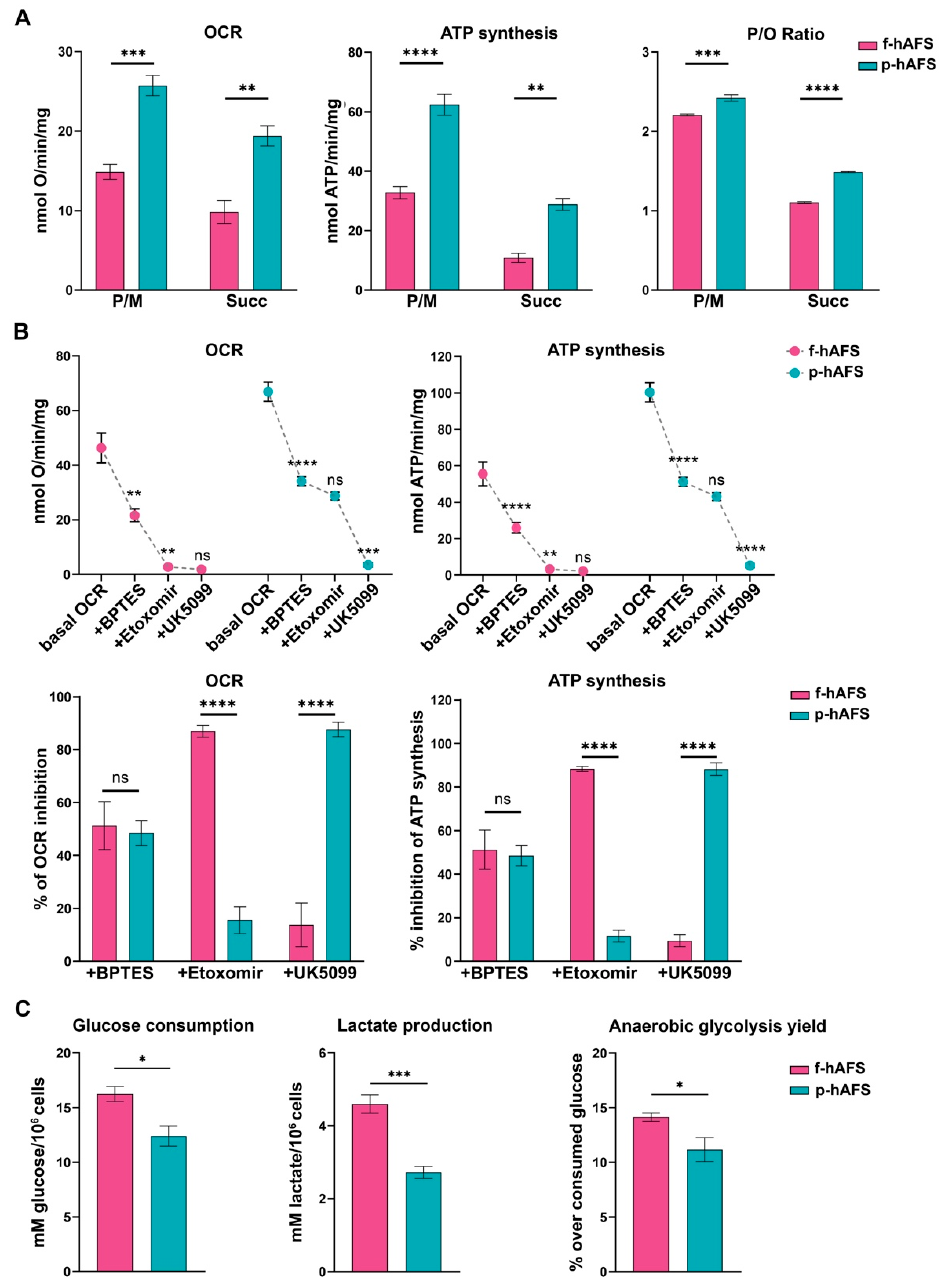
Figure 2. Metabolic characterization of fetal- and perinatal hAFS. ( A ) Oxygen consumption rate (OCR), ATP synthesis through F 1 -F o ATP synthase, and P/O ratio in f-hAFS and p-hAFS in the presence of pyruvate plus malate (P/M) or succinate (Succ); *** p = 0.0005, ** p = 0.0012, **** p < 0.0001, ** p = 0.0013, *** p = 0.0002, **** p < 0.0001. ( B ) OCR and ATP synthesis in presence of BPTES, Etomoxir, and UK5099 (upper panel) was sequentially added during the experiments to evaluate the relative contributions of glutamine, long-chain fatty acid oxidation and glucose in OxPhos metabolism in f-hAFS and p-hAFS. For OCR experiments: f-hAFS + BPTES ** p = 0.0014; for f-hAFS + Etomoxir ** p = 0.0088; for p-hAFS + BPTES **** p < 0.0001; for p-hAFS + UK5099 ** p < 0.0001. For ATP experiments: f-hAFS + BPTES **** p < 0.0001; for f-hAFS + Etomoxir ** p = 0.0013; for p-hAFS + BPTES **** p < 0.0001; for p-hAFS + UK5099 ** p < 0.0001). The comparison of percentage of inhibition of OCR and ATP synthesis in f- and p-hAFS due to the inhibitors indicated above is reported in the lower panel B. For OCR experiments: hAFS + Etomoxir **** p < 0.0001; for hAFS + UK5099 **** p < 0.0001. For ATP experiments: hAFS + Etomoxir **** p < 0.0001; for hAFS + UK5099 **** p < 0.0001). ( C ) Glucose consumption, lactate release and anaerobic glycolysis yield, used as markers of the anaerobic glycolysis, in f-hAFS and p-hAFS. All values are expressed as mean ± s.e.m of n = 4 independent experiments; * p = 0.016, *** p = 0.0008, * p = 0.0416,